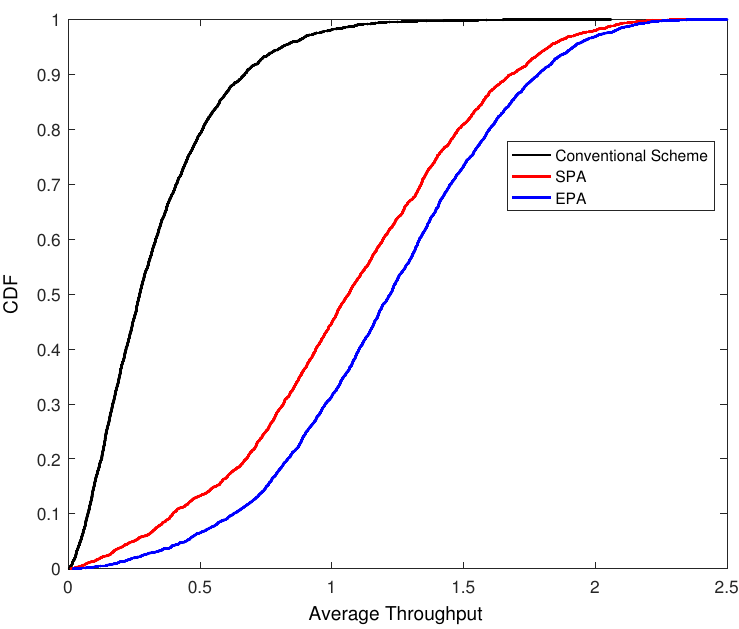
Figure 11. The CDF of average uplink rate when M = 64 using